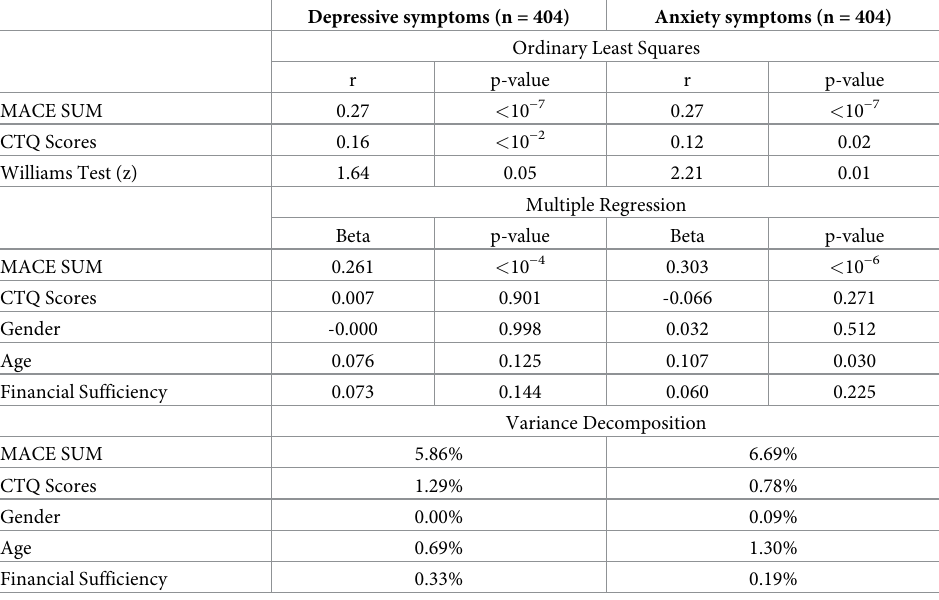
Table 14. Comparative difference between MACE SUM and CTQ